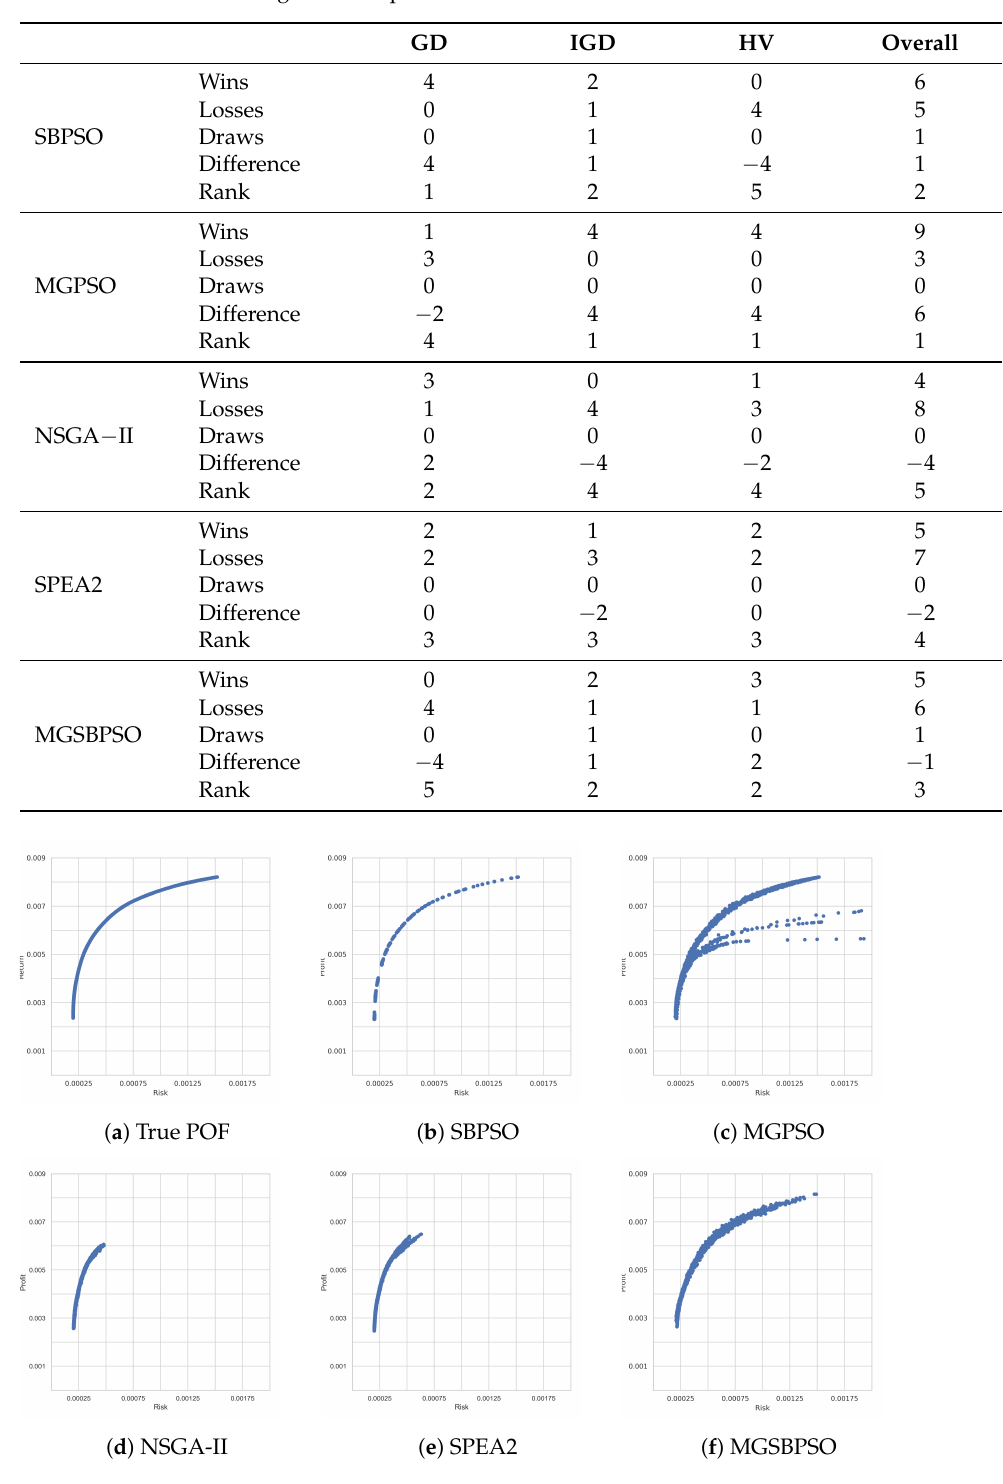
Figure 5. Pareto-optimal fronts obtained for FTSE